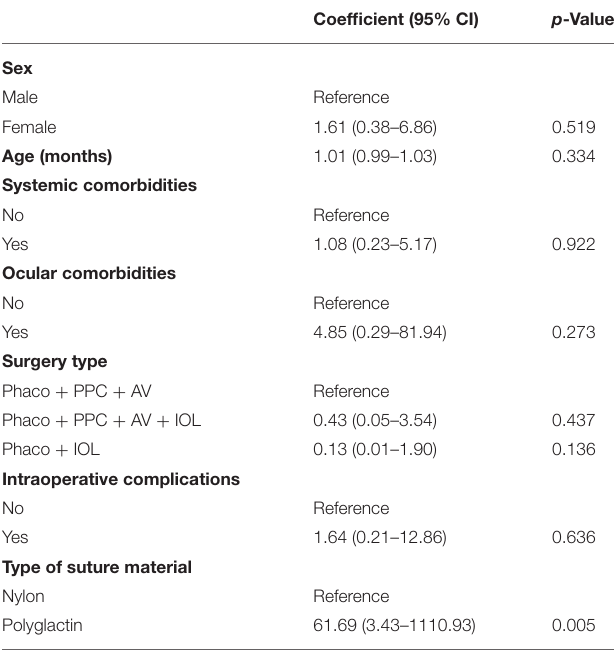
TABLE 4 | Multiple logistic regression analysis applied to suture complications and the need for suture removal in cases of pediatric cataract surgeries with either nylon or polyglactin